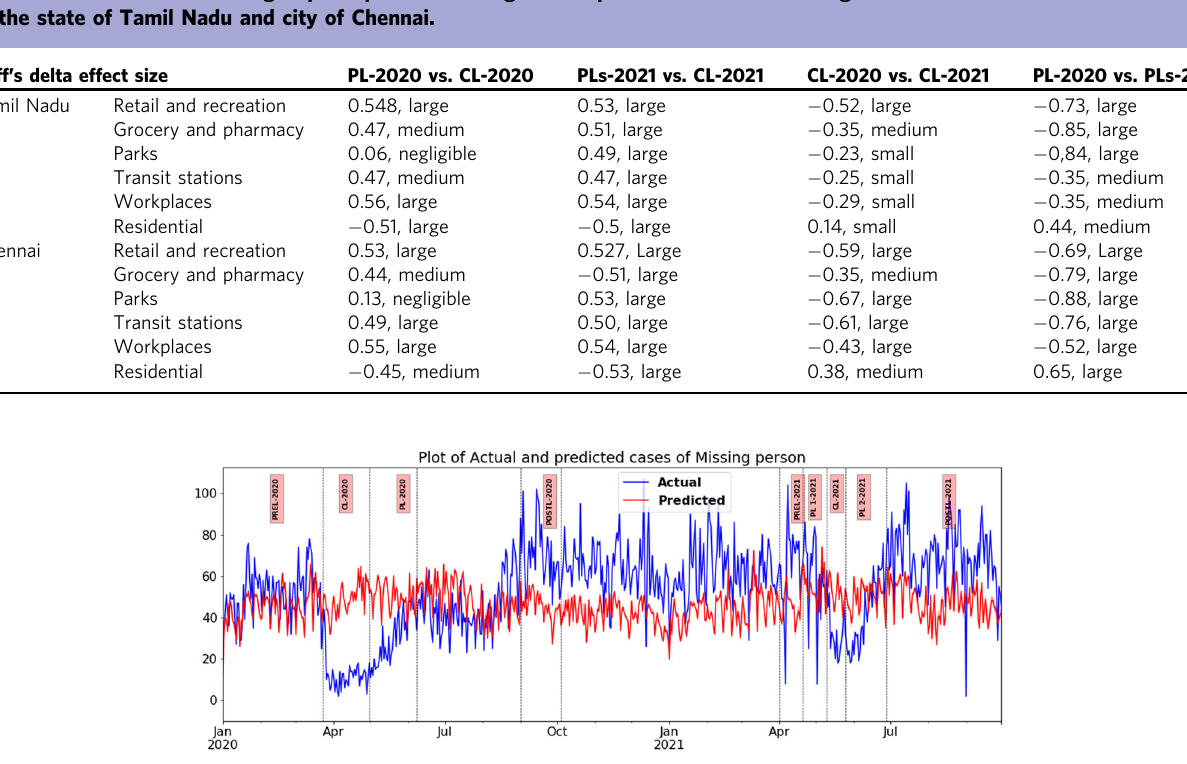
Fig. 7 Plot of actual and predicted number of missing person cases using an auto-regressive neural network. x -axis — timeline of various lockdown phases in both waves in Tamil Nadu. y -axis — daily count of missing person cases registered (actual and predicted). The vertical bars space out the different lockdown phases such as CL — complete lockdown, PL — partial lockdown and Post-L — post